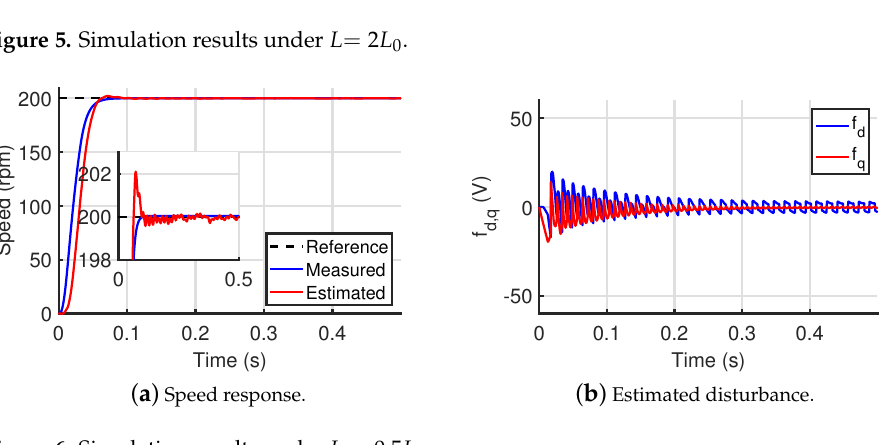
Figure 6. Simulation results under L = 0.5 L 0 .